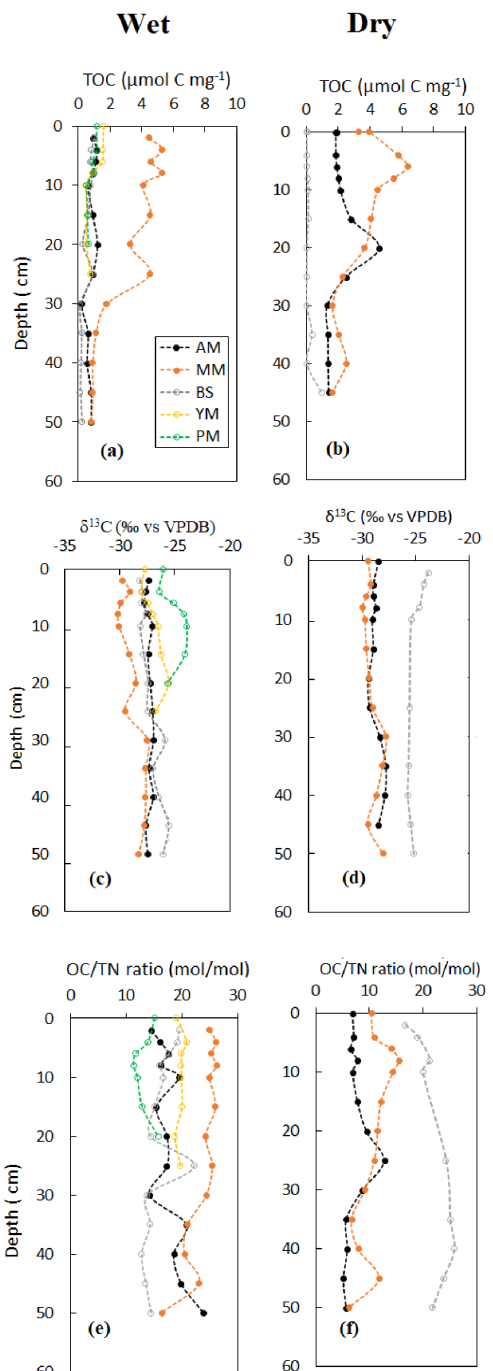
Figure 3. Vertical profiles of sedimentary carbon properties during the wet and dry season.